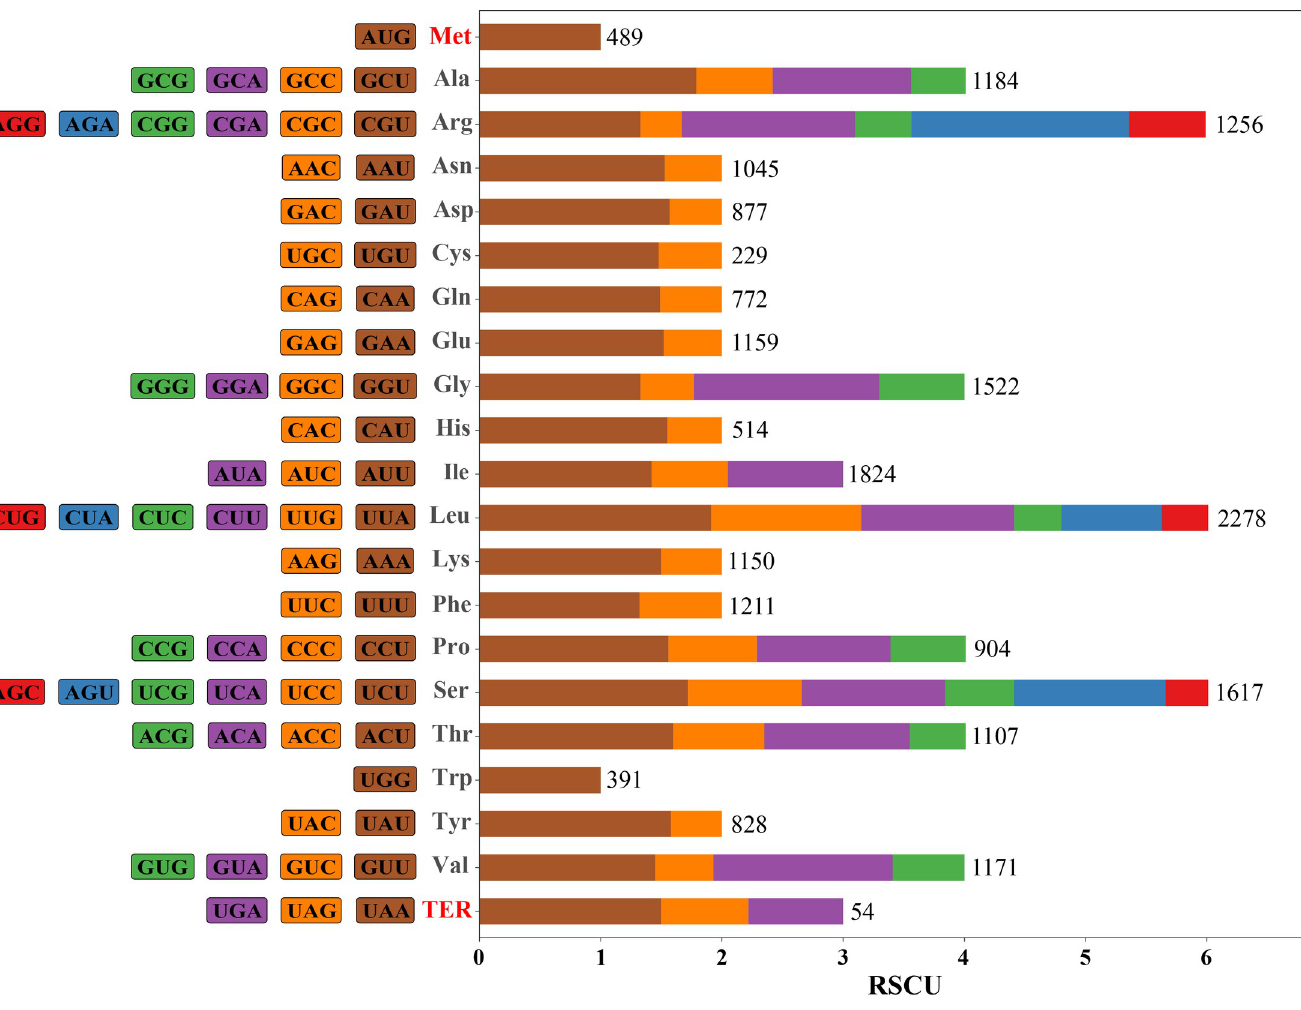
Fig 2. Relative synonymous codon usage (RSCU) analysis of 20 amino acids and three termination codons in Brassaiopsis angustifolia . Bar diagram in different colors reflects codon usage bias (brown, yellow, purple, green, blue, and red, correspond to the proportion of different codons in descending order). Numbers represent codon